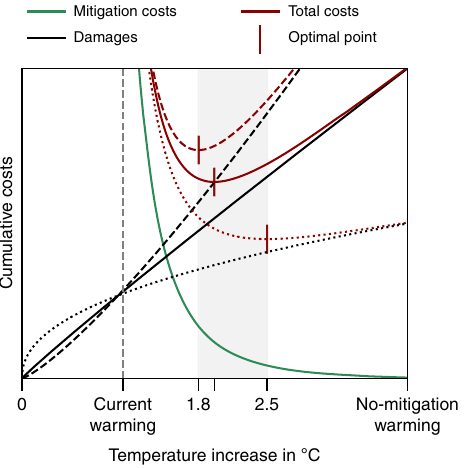
Fig. 1 Illustration of universality of the cost-bene fi t climate analysis. Cumulative mitigation costs (green curve) and climate damages (black curve) as a function of Earth ʼ s warming level give the total climate costs (red curve). Mitigation costs diverge for present-day warming and converge to zero for unmitigated warming. The damages are zero for zero warming and increase with temperature. The characteristic steepness of the mitigation curve implies that beyond a certain damage level the economically optimal temperature (which minimizes the total costs) becomes insensitive to a further increase in damages. For example, increasing (black dashed) or decreasing (black dotted) the damage level by half of the initial damage level does not change the economically optimal warming level signi fi cantly (grey